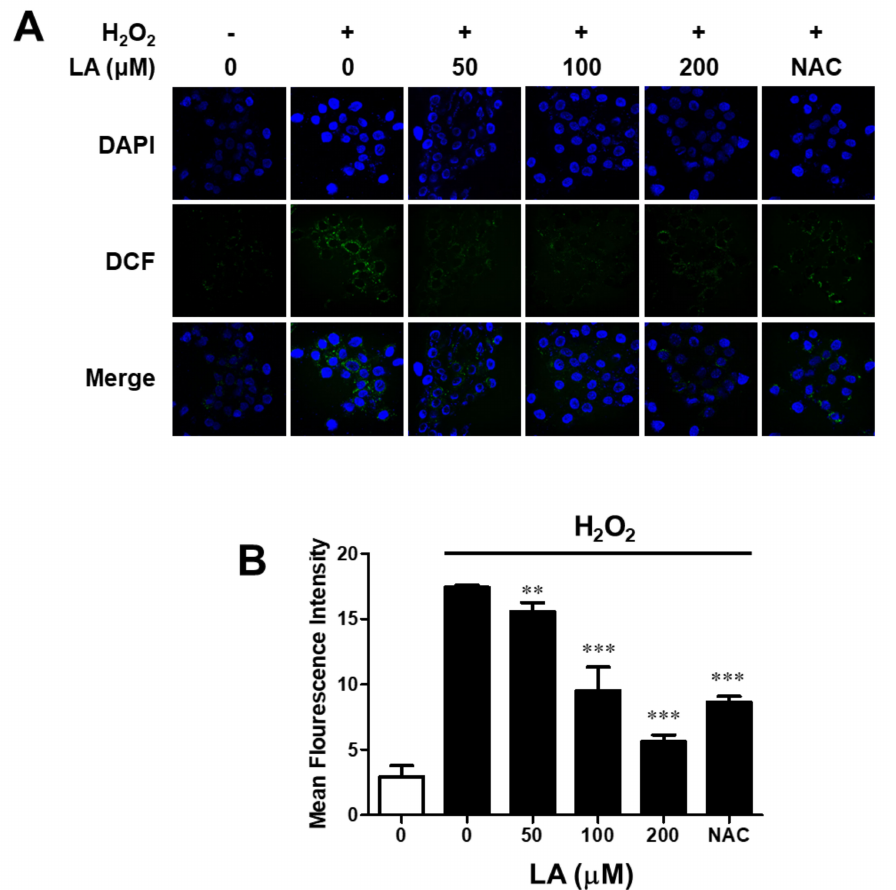
Figure 3. Linoleic acid decreases intracellular ROS synthesis in oxidative stress-induced C2C12 myoblasts. For the estimation of intracellular ROS, DCF was detected using confocal microscopy. ( A ) The effect of LA on intracellular ROS in C2C12 myoblasts identified using a confocal microscope. C2C12 myoblasts were pre-incubated in serum-free DMEM with LA (0–200 µ M) for 24 h, and the medium was replaced with 1 mM H 2 O 2 for 2 h. After incubation, C2C12 myoblasts were treated with 10 µ M DCF-DA in PBS for 30 min, fixed with 4% para -formaldehyde in PBS for 30 min, and mounted using a mounting medium with DAPI. DCF was detected at wavelengths of 485 and 535 nm. DAPI was detected at wavelengths of 358 and 461 nm. The effect of LA was compared with that of 2 mM NAC. ( B ) Quantitating intracellular ROS synthesis. A graph showing average intensity of fluorescence in various GFPs, observed with a confocal laser scanning microscope in the C2C12 myoblast. Data are represented as mean ± SD ( n = 3). ** p < 0.01, *** p < 0.001 vs. H 2 O 2